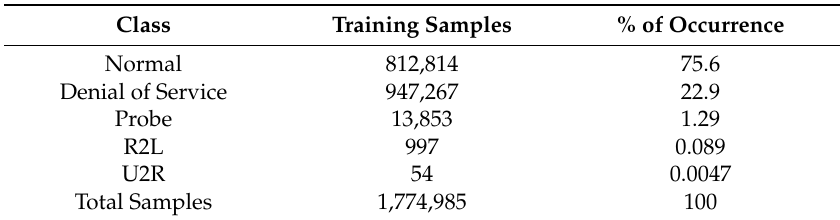
Table 4. Dataset